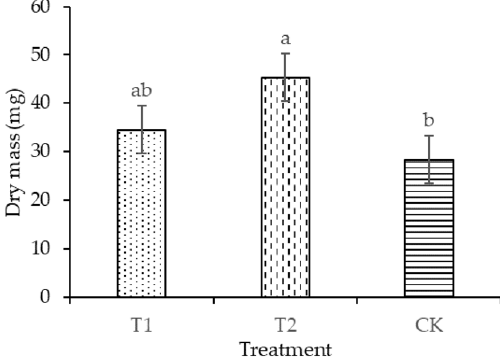
Figure 7. Dry mass in root of seedling under different treatments.